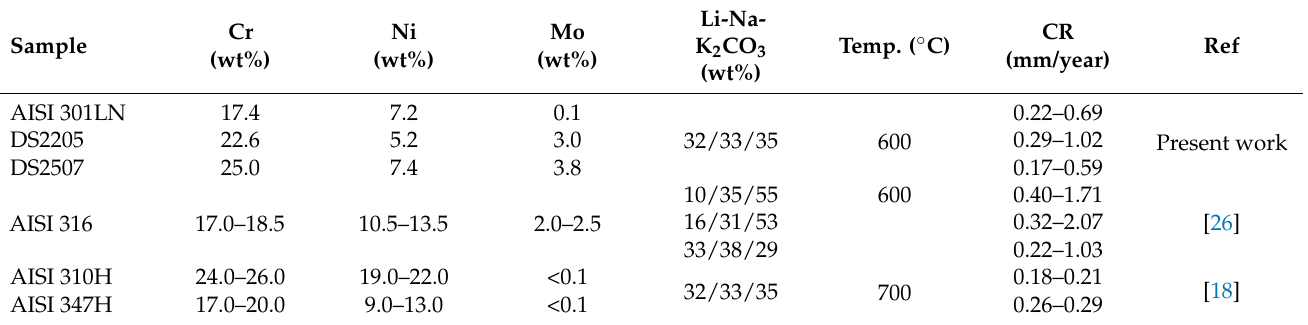
Table 4. Overview of corrosion rates ( CR ) of tested steels, indicating the Cr, Ni and Mo contents in carbonate salts in the range of 600 and 700 ◦